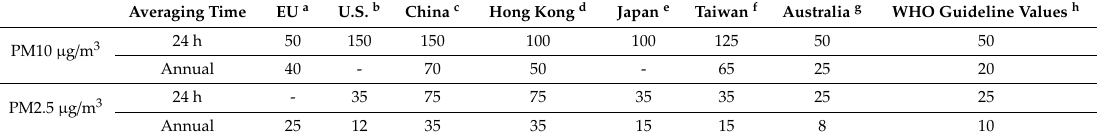
Table 2. Current exposure standards to PM10 and PM 2.5 in Western and Eastern